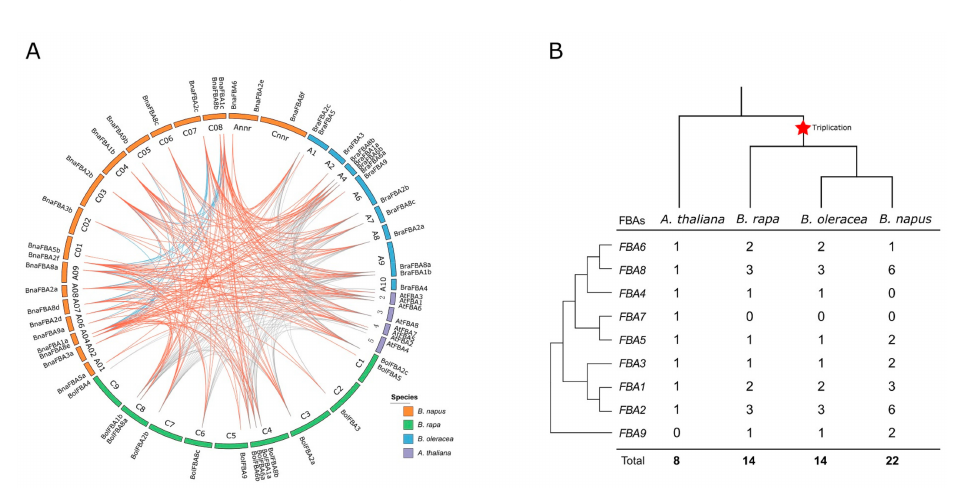
Figure 4. Collinear correlations and copy number variation of the FBA family genes in B. napus , B. rapa , B. oleracea, and A. thaliana . ( A ) Collinear correlations of FBA genes in the B. napus , B. rapa , B. oleracea, and A. thaliana genomes. The B. napus , B. rapa , B. oleracea, and A. thaliana chromosomes were colored by corresponding colors that are shown in the color legend at the bottom right. The blue lines represent the collinear correlations of FBA genes within B. napus, and the orange lines are for the collinear correlations of FBA genes between B. napus and the other species, with the grey lines representing the collinear correlations of FBA genes among B. rapa , B. oleracea, and A. thaliana . The figure was created using CIRCOS software. ( B ) Copy number variation of the FBA family genes in B. napus , B. rapa , B. oleracea, and A. thaliana . The phylogenetic tree of FBA genes is shown on the left, with the species tree shown at the top. The Brassica -specific triplication was indicated on the branches of the trees according to the Plant Genome Duplication Database. The numbers are the copy numbers of each FBA gene in A. thaliana , B. napus , B. rapa, and B. oleracea